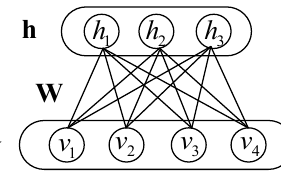
Figure 1. Graphical structure of the RBM.